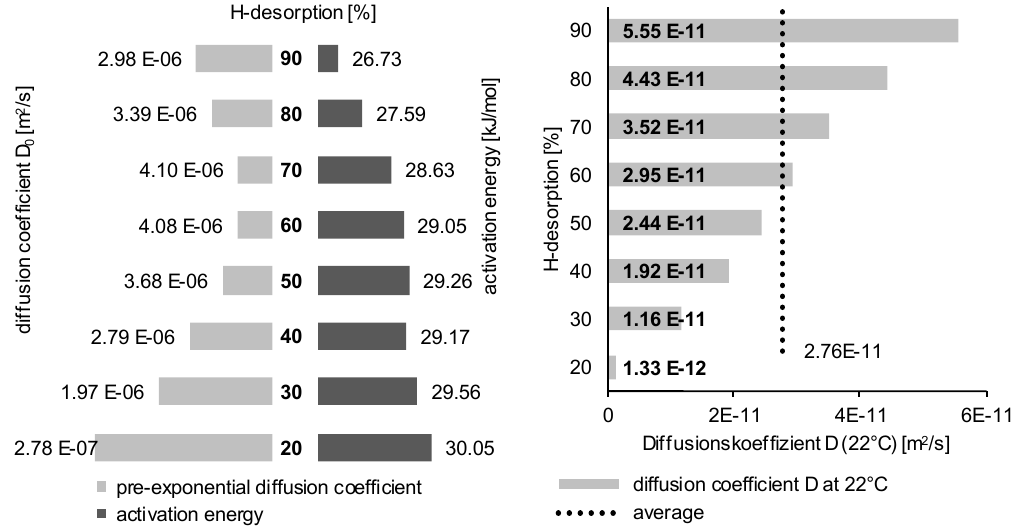
Figure 18. Calculated Ea , D 0 ( left ) and D ( right ) for different stages of desorption.